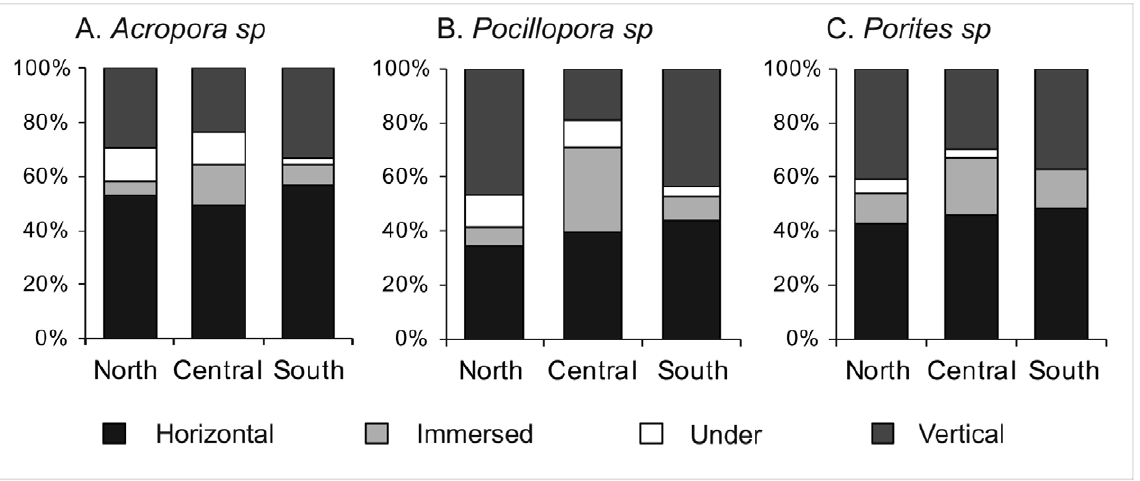
Figure 5. Comparison of surface orientation use by juvenile scleractinian corals across the northern (n=135), central (n=135) and southern reefs (n=135) on the GBR, for (A) Acroporasp, (B) Pocilloporasp , and (C) Poritessp .